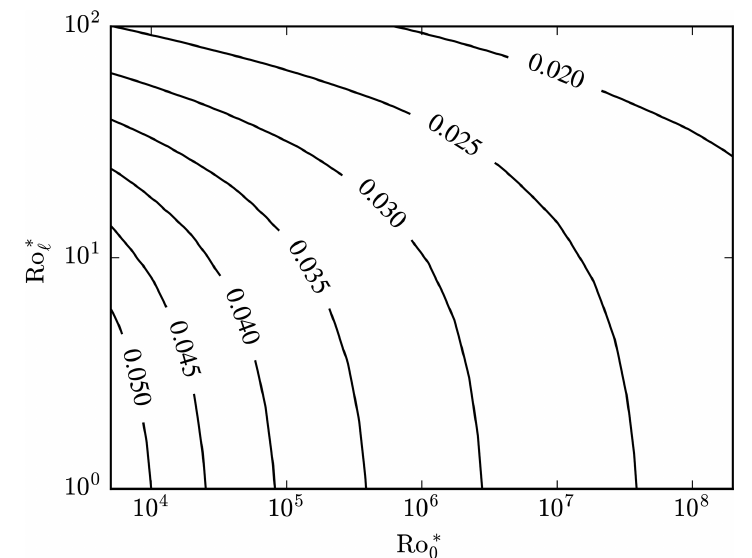
= 0. and Ro ∗ with Ro ∗ L − (cid:96) 0